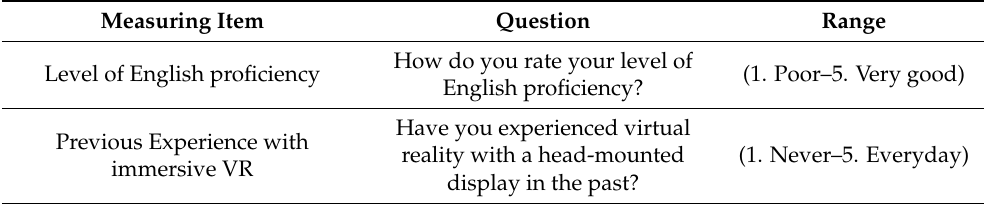
Table 4. Questionnaires used to rate the level of English proficiency, the previous experience with immersive VR, and the perceived uncertainty of Task 1 and Task 2. Measuring Item Question Range How do you rate your level of (1. Poor–5. Very good) Level of English proficiency English proficiency? Have you experienced virtual Previous Experience with reality with a head-mounted (1. Never–5. Everyday) immersive VR display in the past? From the definition of Hillen et al. [28], changes in three sources can provide uncertainty in an information system: probability, ambiguity, or/and complexity of information. You Rating the perceived uncertainty can perceive uncertainty if you of Tasks 1 and 2 can become aware of its existence. Based on this definition and your experiment with the virtual office, what score will you give to the perceived uncertainty of Task 1 (the same question for Task 2)?